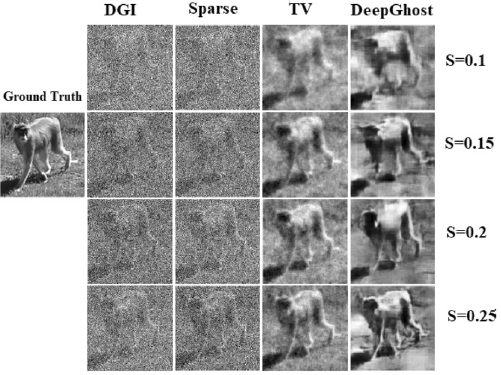
Figure 3. Qualitative comparison of reconstructions from different algorithms.